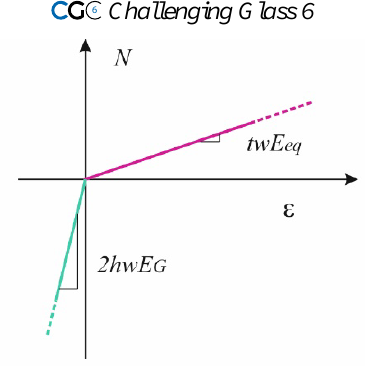
Fig. 8 Qualitative plot of the axial load – axial deformation relation of cracked laminated glass.